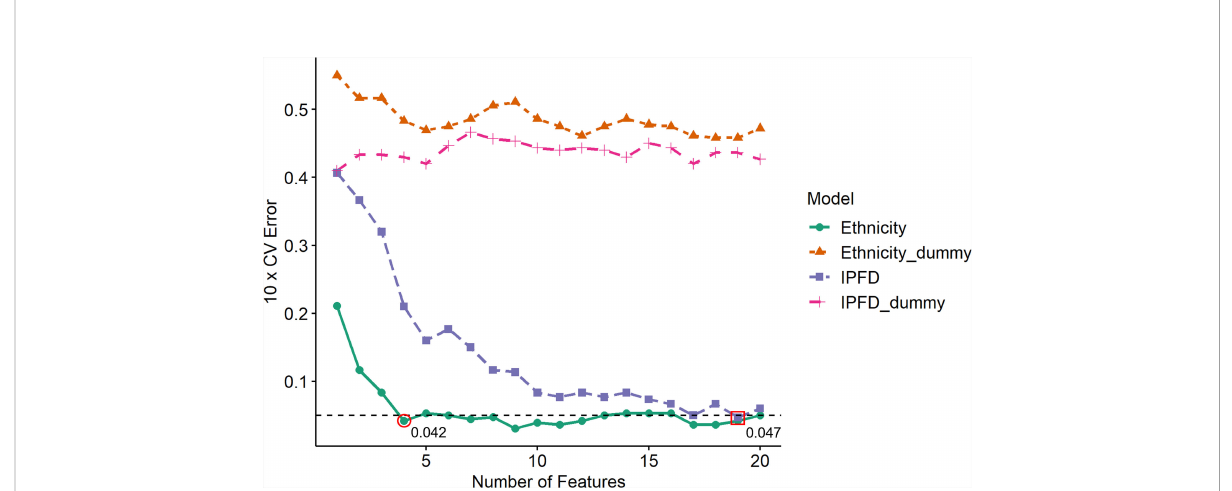
FIGURE 1 Generalized ten-fold cross validation error estimates for each testing set iteration per number of top SVM-RFE input features. Ten-fold CV error estimates depict the prediction accuracy of ethnicity and intra-pancreatic fat deposition (IPFD) models relative to number of top-ranking features input at each testing fold iteration. Ethnicity_dummy and IPFD_dummy models represent respective query model classes against shuf fl ed y axis values (feature vectors), re fl ecting the classi fi cation legitimacy of each query model. Horizontal dotted line indicates threshold for optimal features input for an acceptable error estimate value (< 0.05) for model prediction. Red circle denotes the minimum number of input features to obtain an optimal error estimate to classify Ethnicity as a model. Red square denotes the minimum number of input features to obtain an optimal error estimate to classify IPFD as a